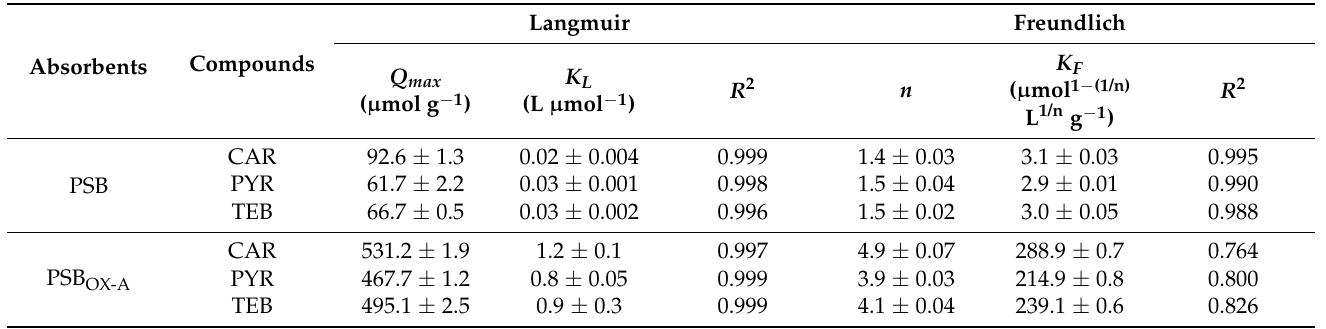
Table 4. Isotherm parameters for the adsorptions of fungicides using PSB and PSB OX-A (agitation speed = 150 rpm; contact